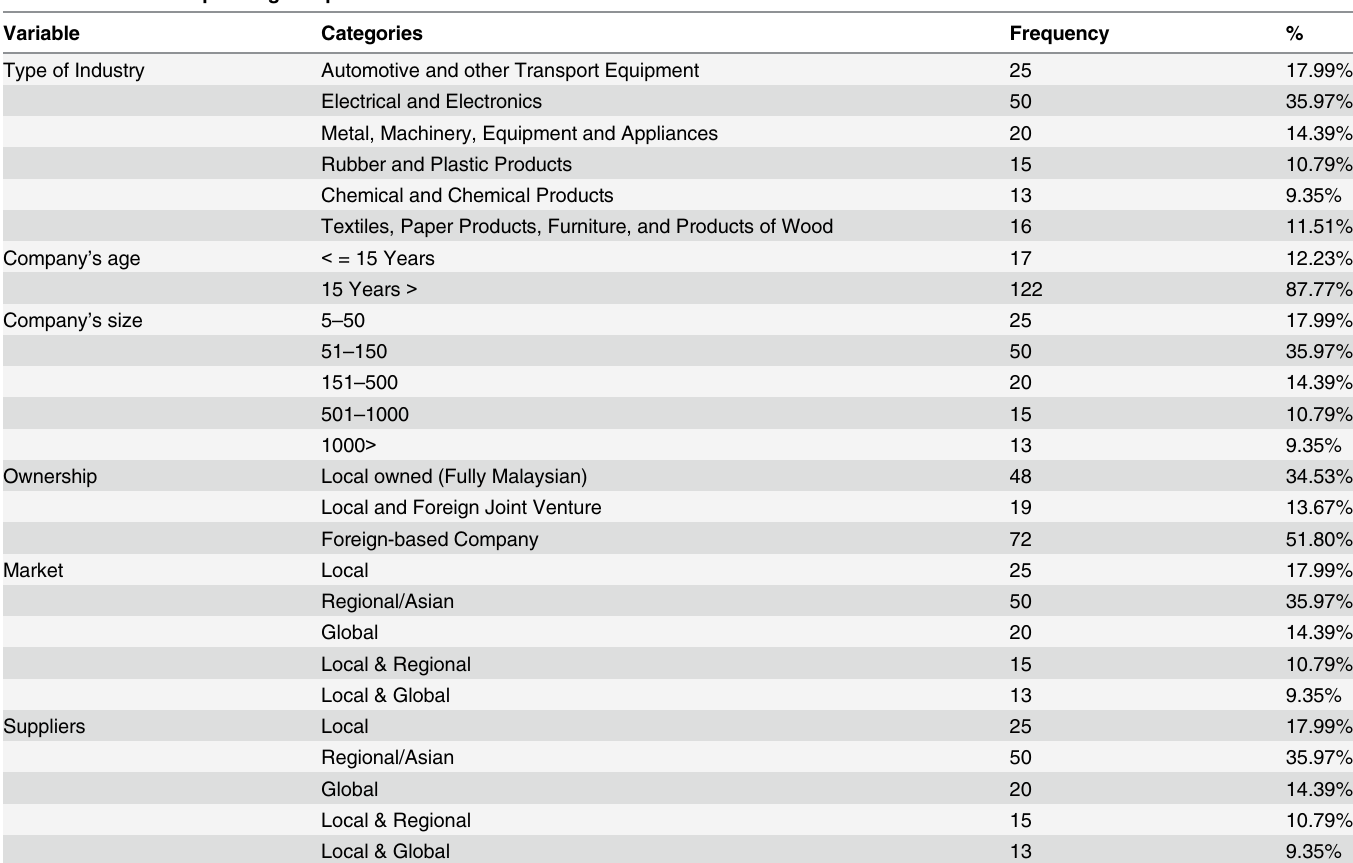
Table 2. Profile of responding